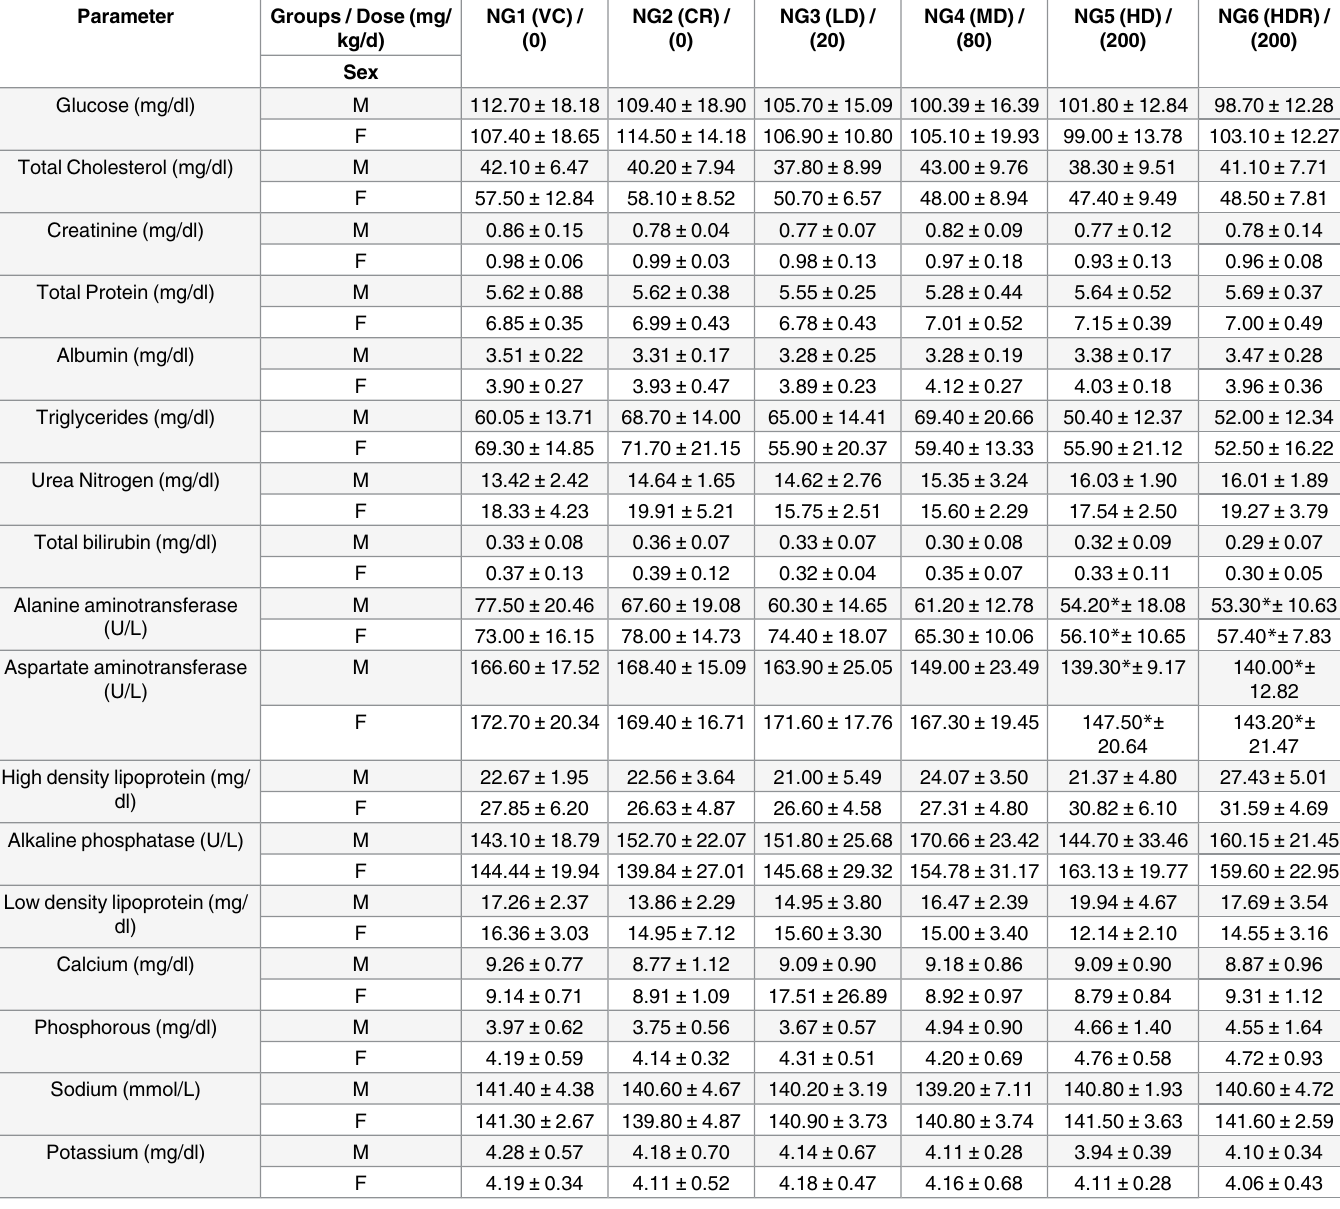
Table 4. Effect of 90 day oral administration of 3’-HPT on biochemical data of male and female SD rats.